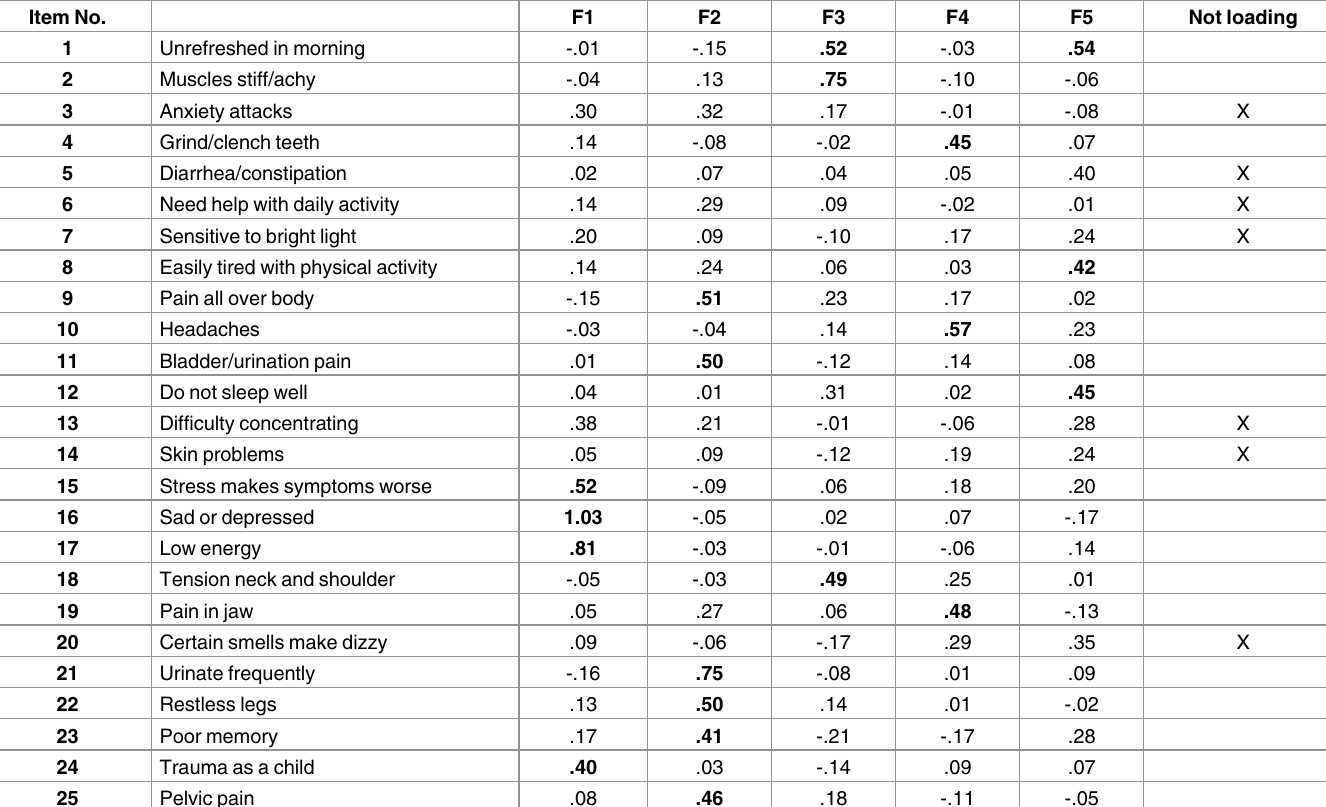
Table 5. Factor loadings of the exploratory factor analysis with promax rotation.